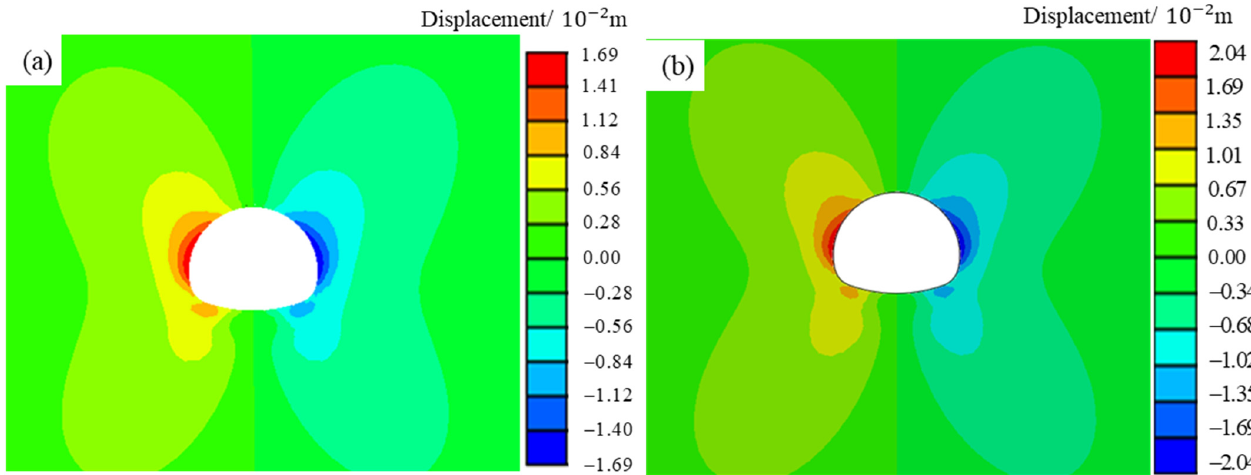
Figure 17. Transverse displacement nephogram of surrounding rock after excavation: ( a ) non-softening; ( b ) dual softening.